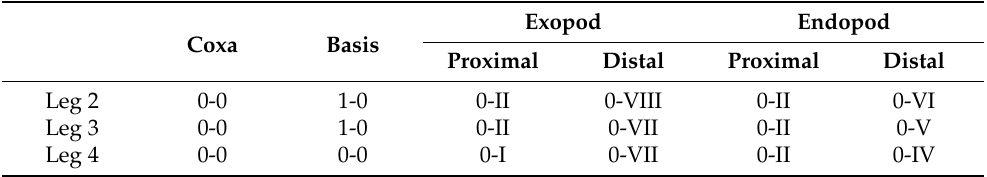
Table 1. The setal formula of rami of legs of the female Nemesis santhadevii sp. nov. (Roman numerals indicate the spine and the Arabic numerals indicate the